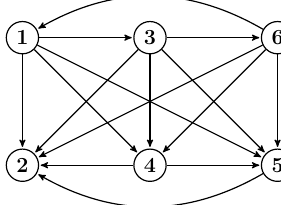
Figure 5: Unilateral tournament ( a